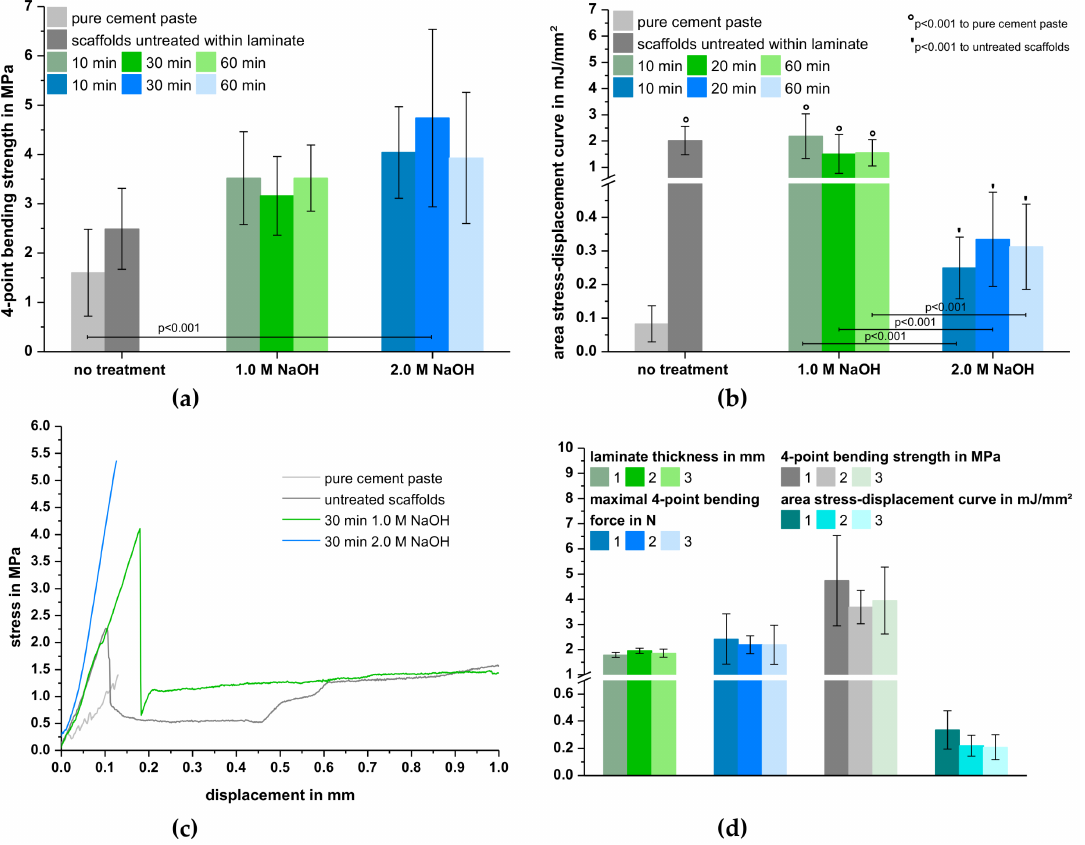
Figure 6. 4-point bending strength ( a ), area under the stress-displacement curves ( b ) and selected stress-displacement curves ( c ) of cured laminates from oil-based CPC paste and 3 layers of SES PCL scaffolds with and without treatment in 1.0 or 2.0 M NaOH. Exemplarily, reproducibility regarding